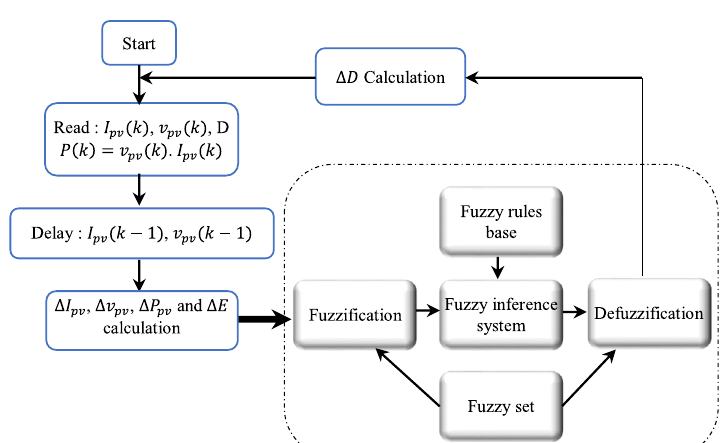
Fig. 5 Fuzzy MPPT algorithm